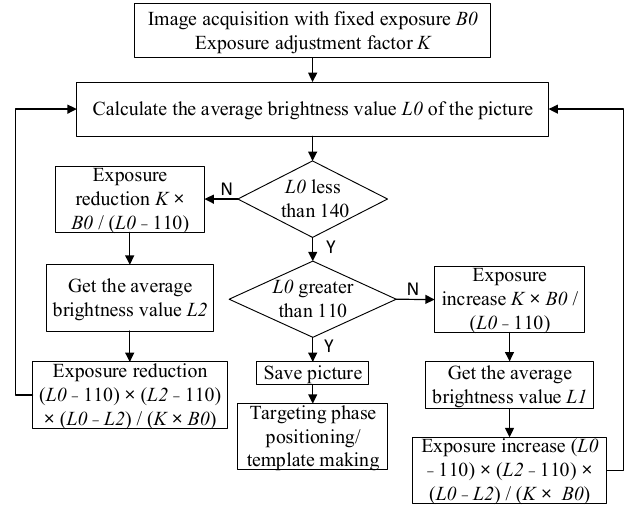
Figure 6. The flowchart of the automatic exposure algorithm.